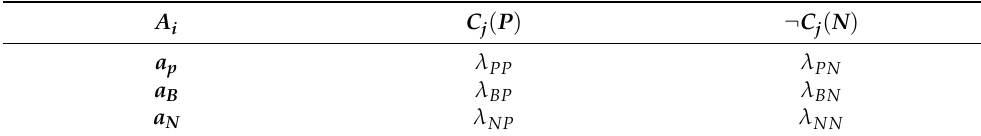
Table 5. The loss